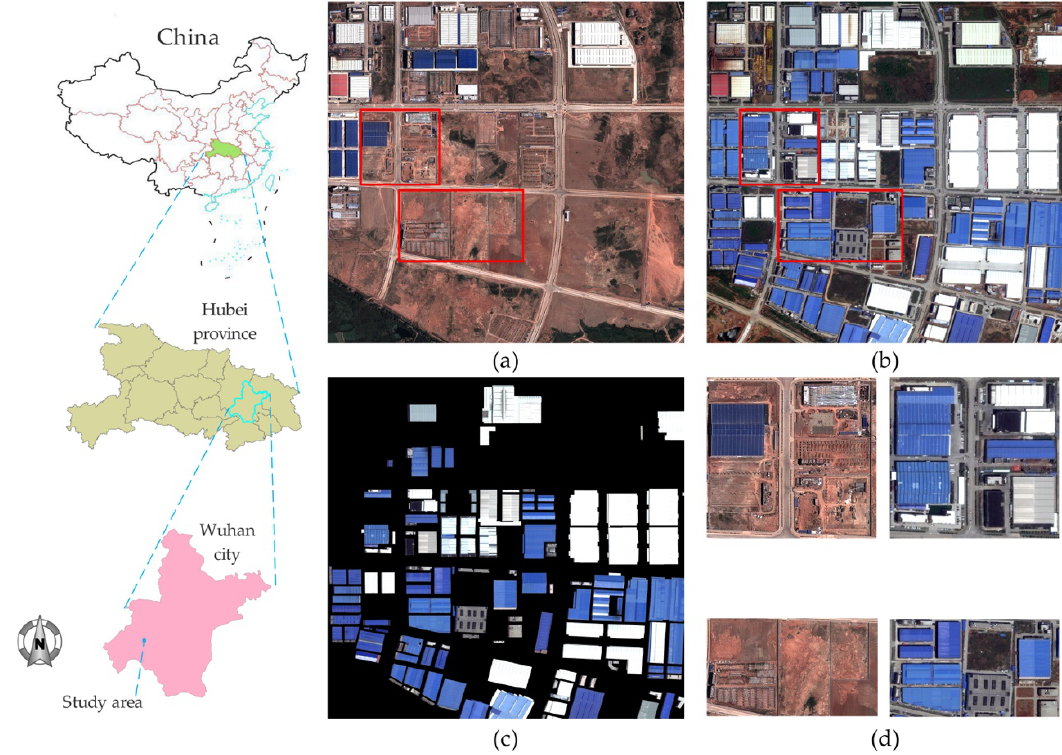
Figure 5. Study data: ( a ) image captured in 2013; ( b ) image captured in 2017; ( c ) ground truth of changed buildings; and ( d ) pertinent details of the two images.